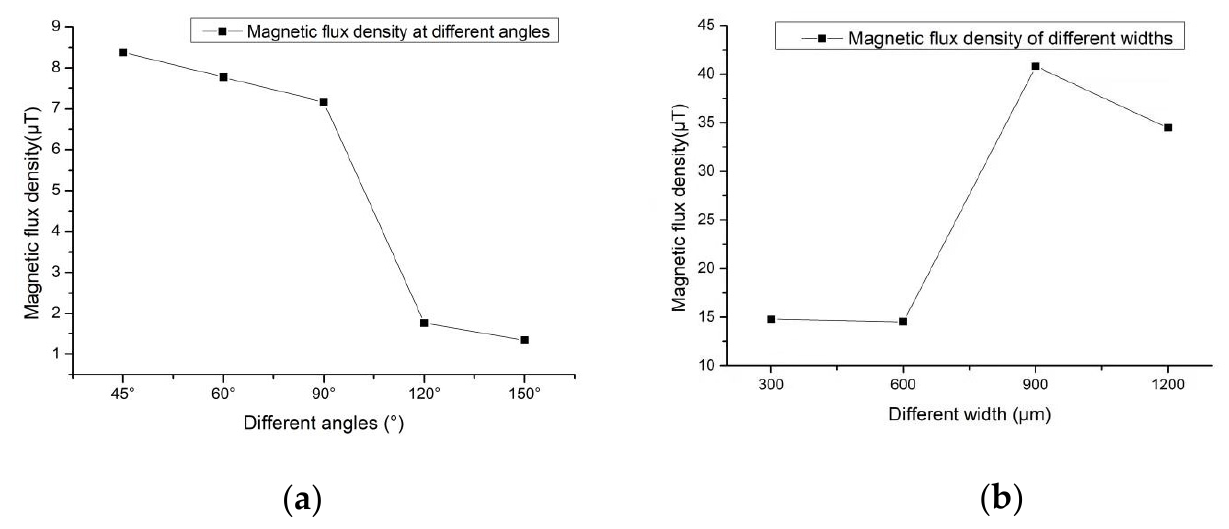
Figure 4. Results of different triangular and rectangular notches: ( a ) Corresponding results in Figure 3; ( b ) Corresponding results in Figure